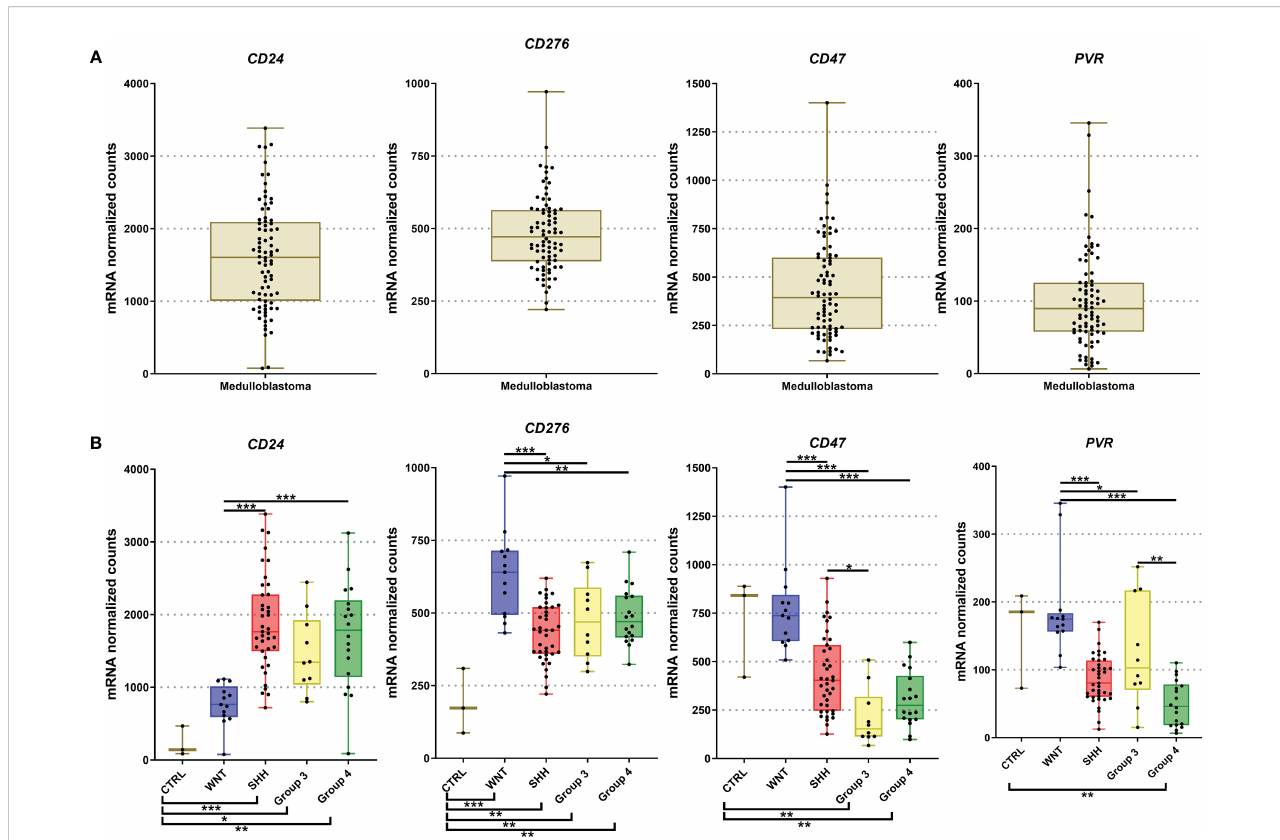
FIGURE 5 Graphic representation of CD24, CD276, CD47, and PVR mRNA levels obtained from our 80 medulloblastomas cohort submitted for analysis by nCounter assay. (A) The plot of mRNA levels of all medulloblastomas for CD24, CD276, CD47, and PVR; (B) Plot of CD24, CD276, CD47, and PVR mRNA levels by molecular subgroups. The signi fi cance level is 0.05. * < 0.05; * < 0.01; *** < 0.001. The plots were obtained through GraphPad Prism 8.